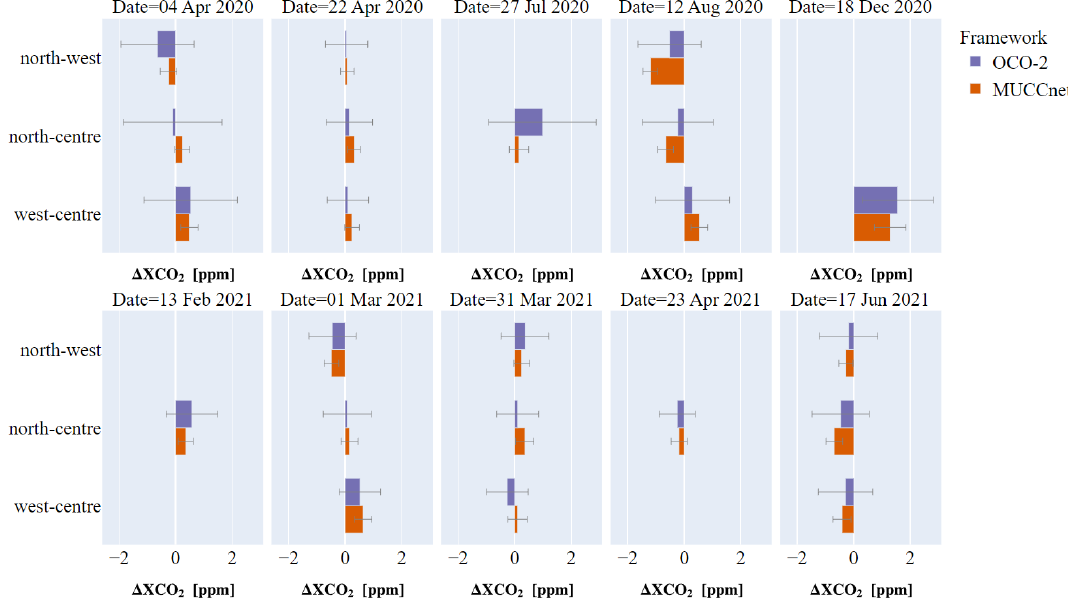
Figure 11. X CO gradients in Munich on overpass days. Blue bars represent the gradients present in the OCO-2 target observations. Orange 2 bars denote X CO gradients captured by MUCCnet. On most days, OCO-2 sees elevated X CO 2 MUCCnet instruments. Error bars are computed using the combined standard deviations of the X CO gradient (see Eq.